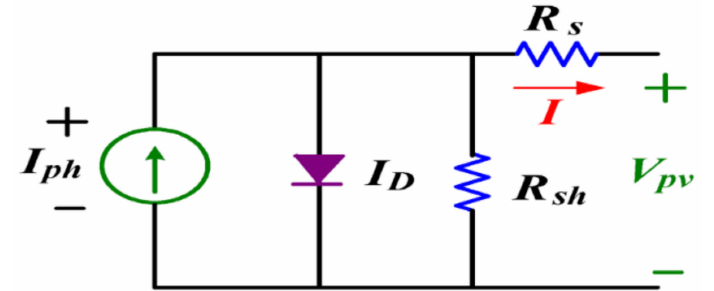
Figure 1. Diagrammatic representation of the photovoltaic system.